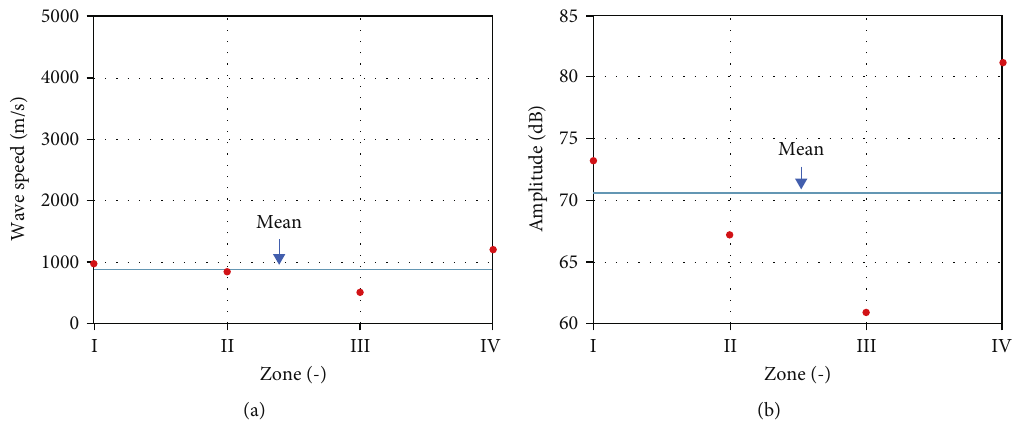
Figure 8: Fractured sandstone dispersion plot. (a) Wave speed dispersion plot. (b) Amplitude dispersion